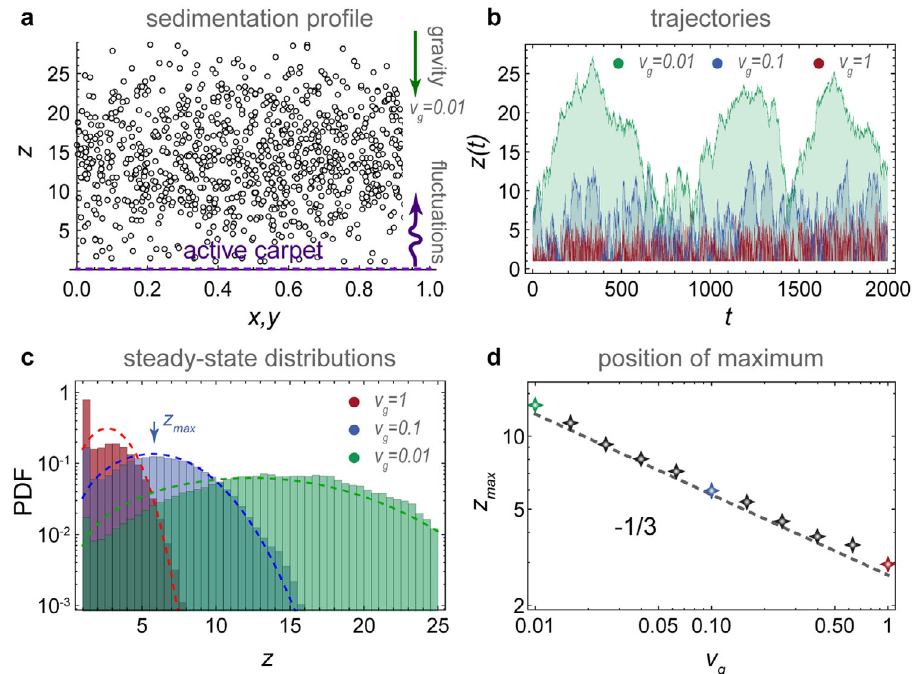
Fig. 3 Sedimentation towards an active carpet. Particles sink with velocity v g due to gravity, but are pushed up by the active fl uctuations generated by the carpet (dashed purple line), which in this case is composed of moving parallel Stokeslets. a Diagram showing the steady-state sedimentation pro fi le. b Typical trajectories z ( t ) for a range of sedimentation velocities v g . c Steady-state distributions of particle density for different v g . Histograms show simulations and dashed lines are the prediction of Eq. (8). d Position of the maximum particle density as a function of v g . Markers show simulations and the dashed line is Eq.